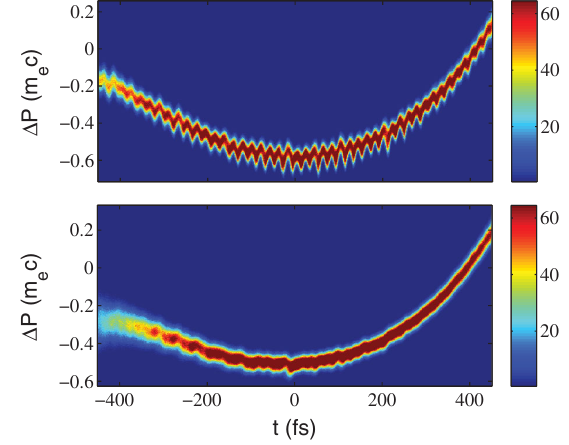
FIG. 5. Longitudinal phase space (time momentum) of the central part of the beam with the energy chirp removed at the exit of TGU2 with TGUs off (upper) and on